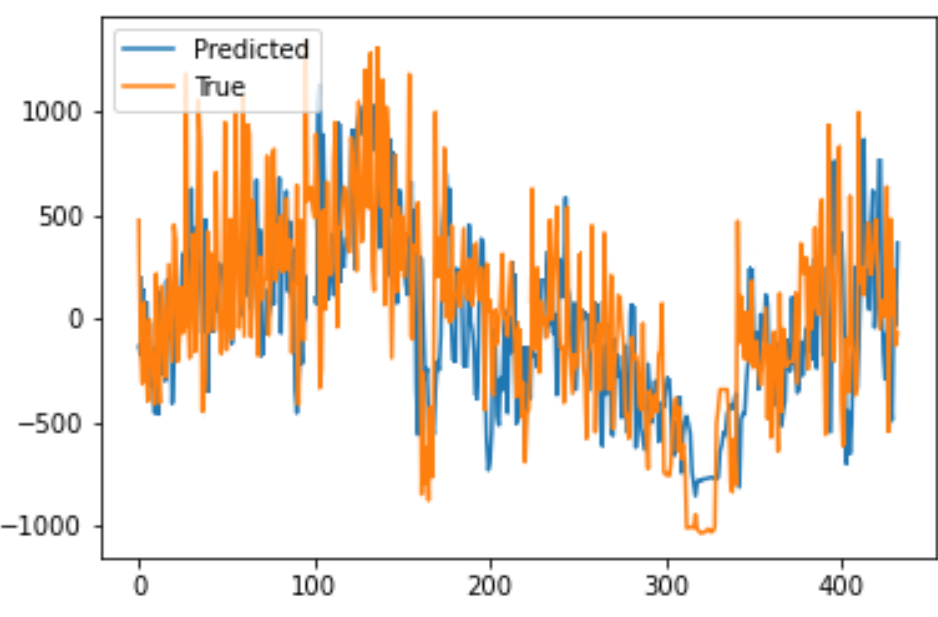
Figure 4. Hourly forecasting performance.